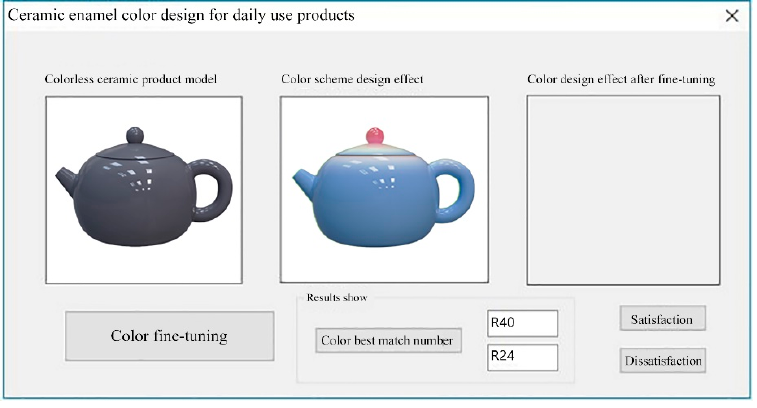
Figure 9. Ceramic daily use product re-color effect.